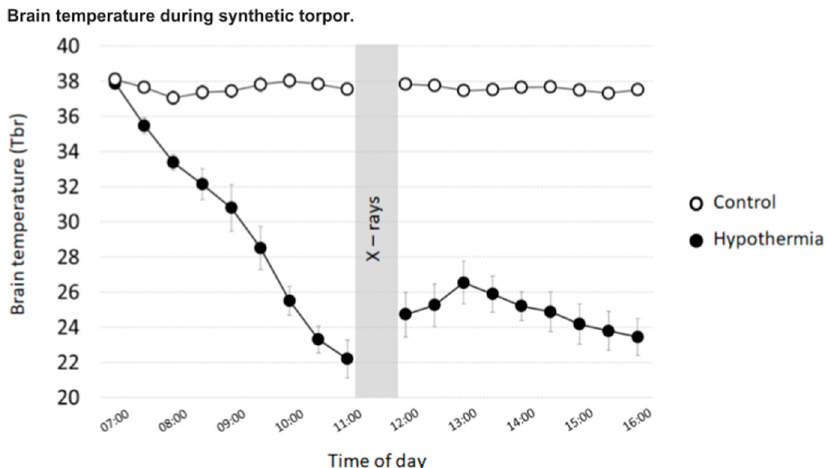
Figure1. Thirty-minmeanvalue ± SEMofthebraintemperature(Tbr), recordedduringtheexperimental day. Tbr was recorded by means of a thermistor, surgically implanted in the Lateral Hypothalamus. Empty dots: Control ( n = 5), filled dots: Hypothermia ( n = 5).